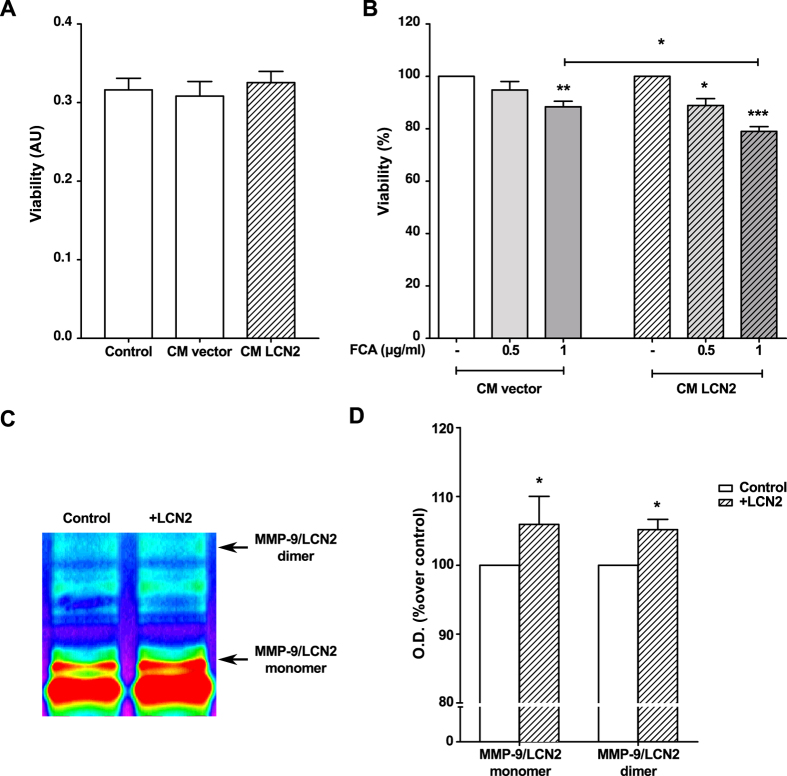
Effects of LCN2 gene expression in MC3T3 cells.Twenty-four hour CM from MC3T3 cells transfected with empty vector (CM vector) or LCN2-containing plasmid (CM LCN2) was used to stimulate MC3T3 cells for 48 h. The effect of LCN2-enriched medium on cell vitality was determined by the MTT assay in the absence (A) or presence (B) of an iron donor (ferric citrate ammonium, FCA) at 0.5 or 1 μg/ml. Additionally, 30 ng/μl of recombinant mouse LCN2 was incubated for 1 h at 37 °C with MC3T3 cell CM to detect the effect of LCN2 on MMP-9 activity by gelatine zymography. A cropped image of the gel is shown. The full-length gel is presented in Supplementary Fig. 6. (C). Gelatinolytic activity was measured by densitometry for both the MMP-9/LCN2 monomer and dimer (D). The results are presented as the mean ± SEM of at least three independent experiments and expressed as a percentage of the non-stimulated control (B,D) (*p < 0.05, **p < 0.01, ***p < 0.001).